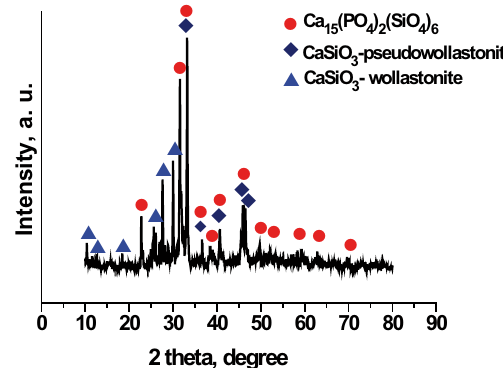
Figure 1. XRD patterns for the obtained calcium phosphate silicate, annealed at 1200°C/2